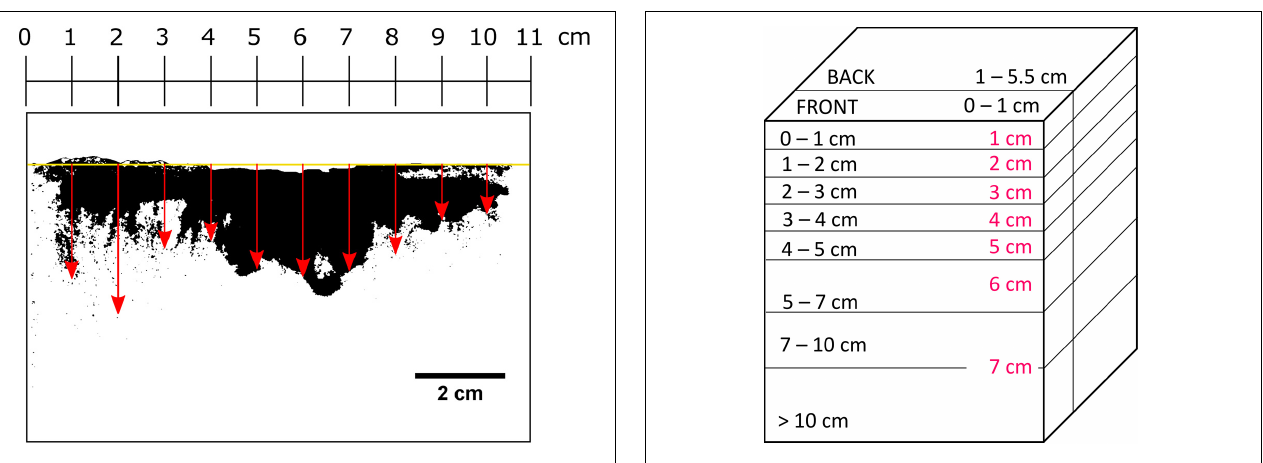
FIGURE 6 | Sediment sectioning. Sediment was vertically sectioned into the front (0–1 cm from the plate) and the back (1–5.5 cm) of the SPI-PUSH. Horizontally the sediment was cut into 1 cm slices at the top (0–5 cm) and bigger slices at the bottom (5 to > 10 cm) of the chamber. Pink numbers represent the respective numbers used in figures